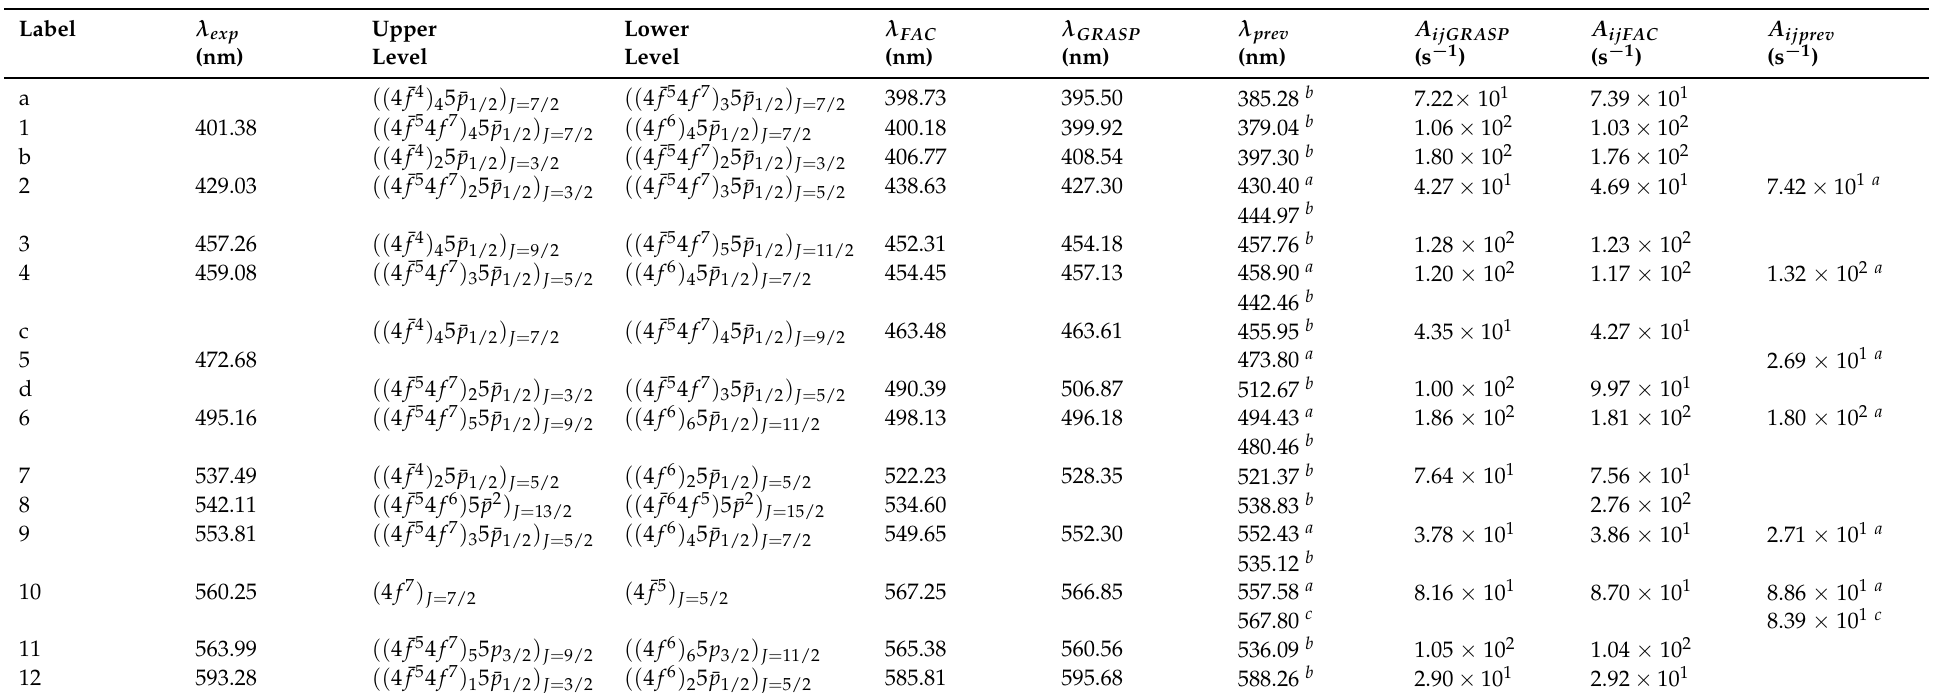
Table 1. Experimental and theoretical wavelengths (nm) and theoretical transition probabilities A (s − 1 ) for transitions in Pm-like W 13 +